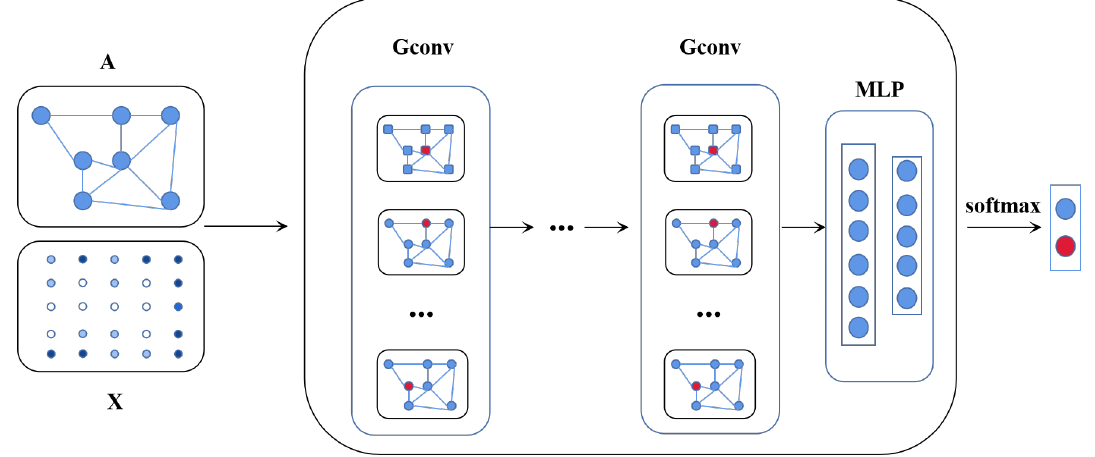
Figure 3. The structure of node classification model